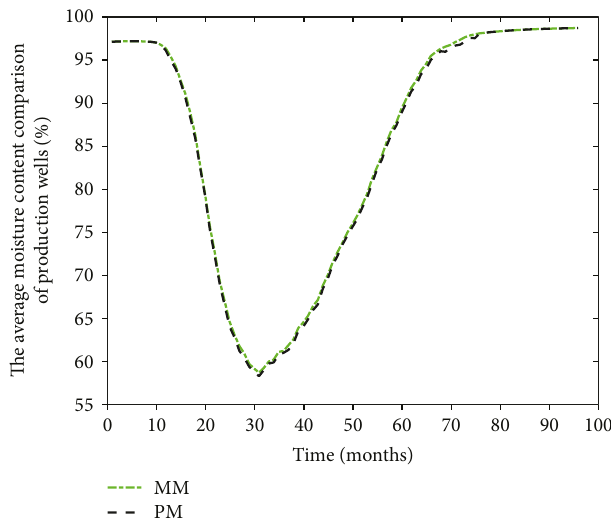
Figure 14: The average moisture content comparison of production